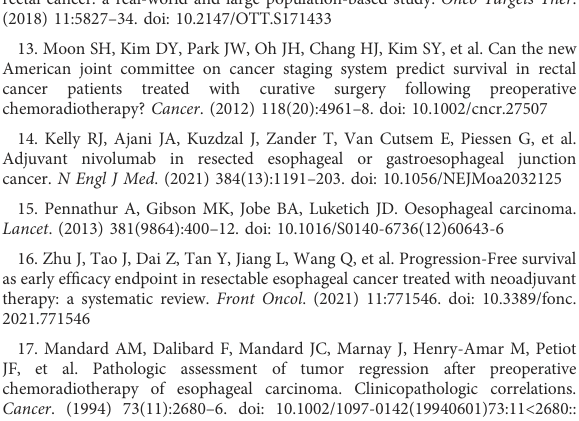
SUPPLEMENTARY FIGURE S1 Nomogram predicting the disease-free survival (DFS) for patients undergoing neoadjuvant chemoradiotherapy and esophagectomy. For every patient, 2 lines are drawn upward to determine the points received from the 2 predictors in the nomogram. The sum of these points is located on the ‘ Total Points ’ axis. In addition, a line is drawn downward to determine the possibility of 12-, 24-, 48-, and 60-month DFS, and the median DFS for patients with the same total score. SUPPLEMENTARY TABLE S1 Multivariate Cox regression model using a backwards model selection